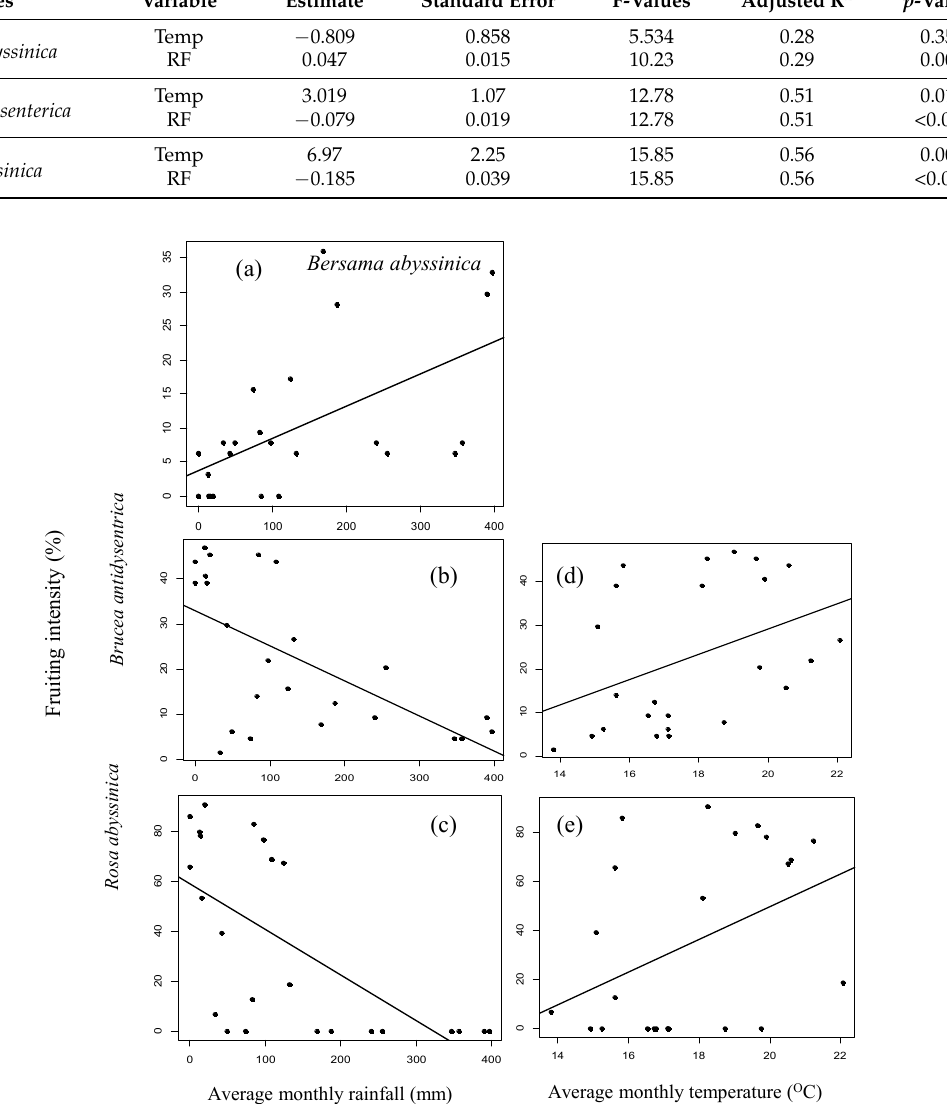
Table 3. The linear regression model showing the effect of mean monthly temperature (°C) and rainfall on the fruiting percent of species.